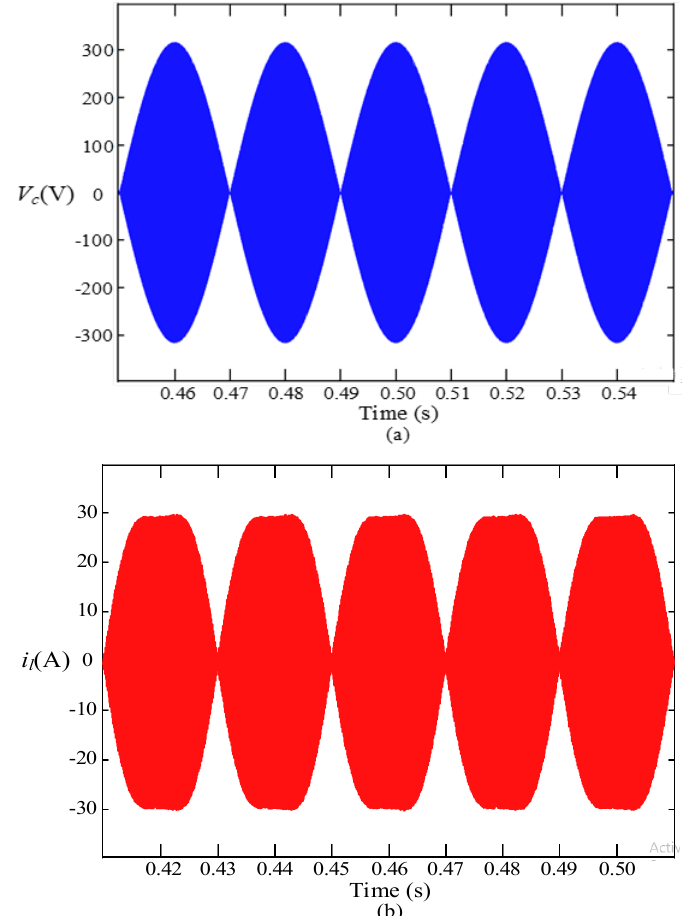
Figure 8. Simulation results ( a ) Resonant capacitor voltage V c and ( b ) Resonant inductor current i 1 .